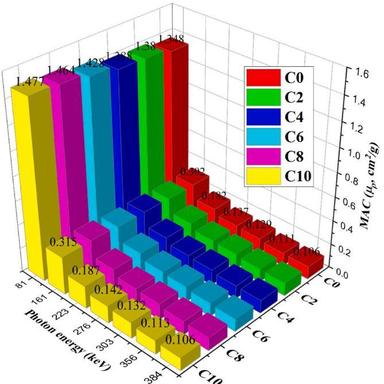
Variation of mass attenuation coefficient (MAC) against photon energy for fabricated glasses.